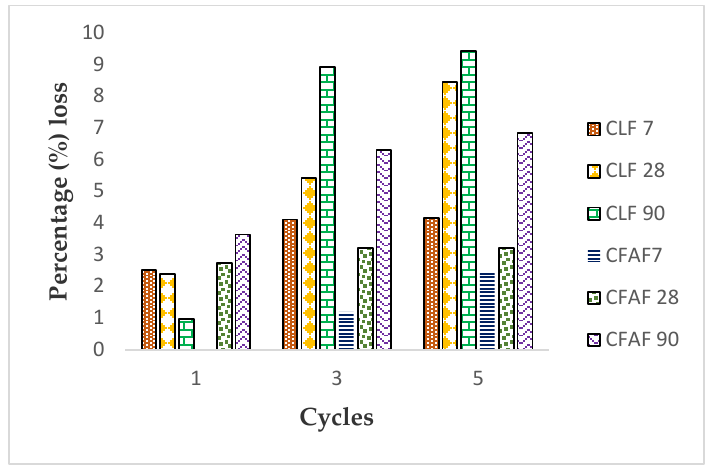
Figure 8. Percentage (%) of weight soil loss versus wetting/drying cycles.